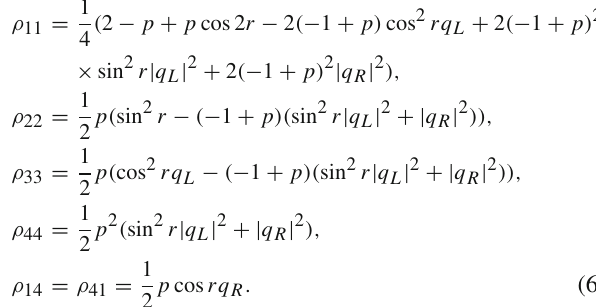
approximation, the ADC is given by its Kraus representa- † † (ρ ) = K ρ + K ρ , with K 0 = tion as E ADC √ 0 i 0 0 i K 1 0 i K |+√ i 0 1 | 0 (cid:4)(cid:9) 0 p | 1 (cid:4)(cid:9) 1 | and K 1 = 1 − p | 0 (cid:4)(cid:9) 1 | ,where p = e − (cid:5) 1